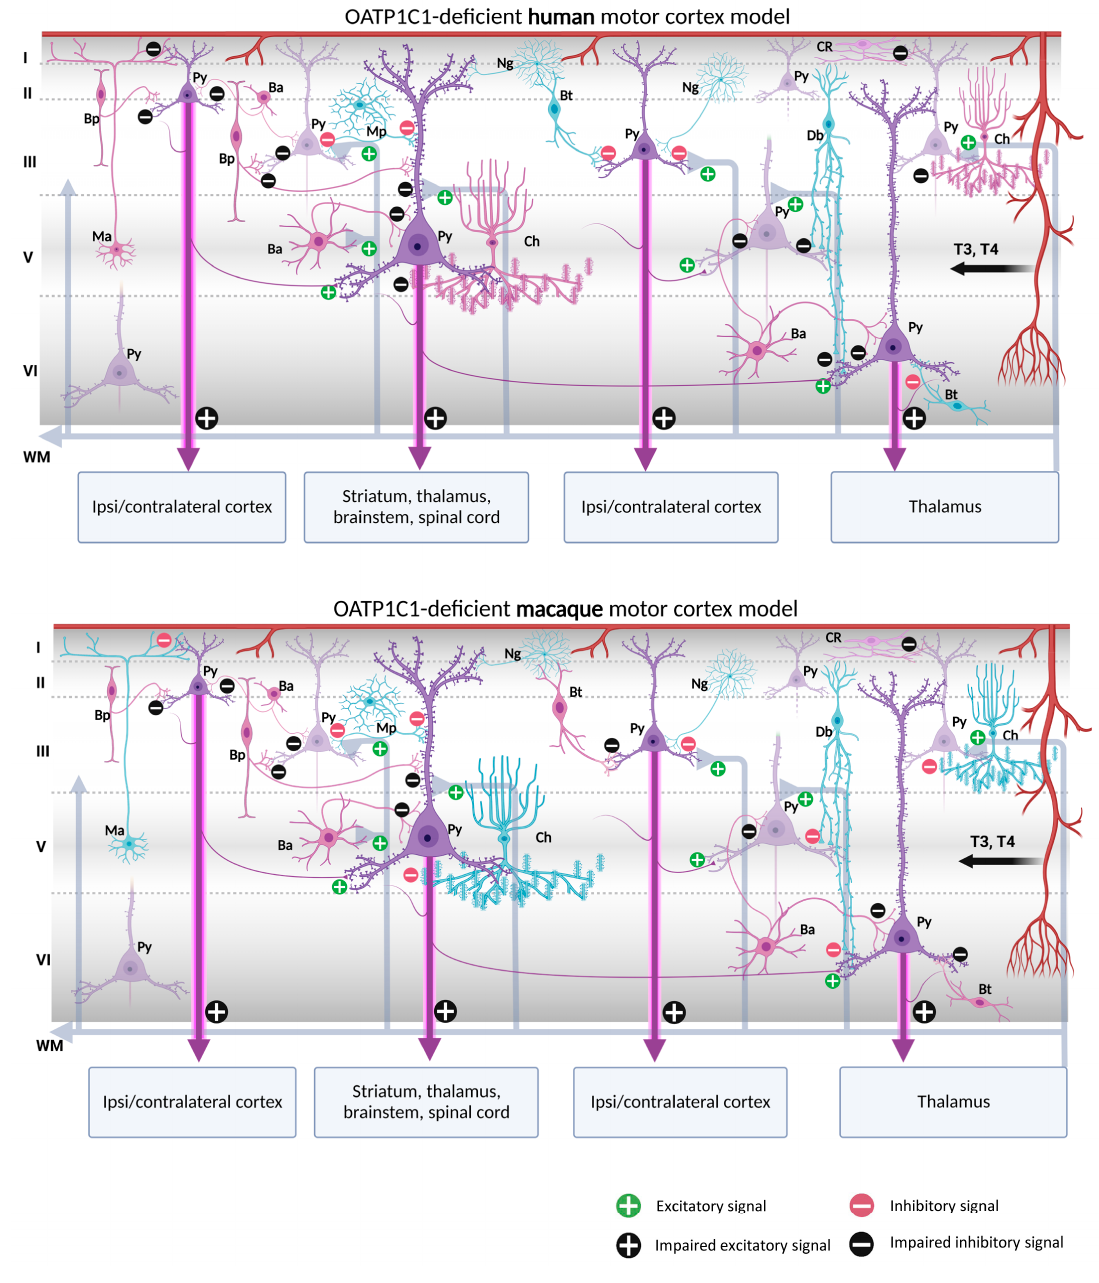
Figure 11. Models of human and macaque OATP1C1-deficient motor cortices. The models include our results and show possible cortical functional microcircuitry physiopathogenic mechanisms. The models might explain some of the symptoms generated in OATP1C1-deficient syndromes. Pyramidal cells and interneurons expressing OATP1C1 are shown in purple. Interneurons non-expressing OATP1C1 are shown in blue. The lack of T4 (and thus decreased deiodination by the astrocytes) may cause trophic deficits in pyramidal cells and interneurons, generating hyperexcitation on pyramidal cells due to the possible abnormal inhibitory function of the interneurons. Abnormalities in pyramidal cells may cause irregularities in their excitatory output signaling to intrinsic and extrinsic targets, producing symptoms such as spasticity, hypertonia, hyperreflexia, epilepsy and others, depending, for example, on the final dendritic activity. Ba: basket cell, Bp: bipolar cell, Bt: bitufted cell,